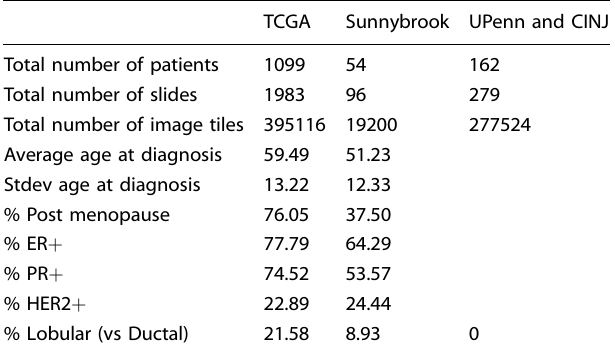
Table 1. Demographics summary of TCGA, Sunnybrook, University of Pennsylvania and the Cancer Institute of New Jersey (UPenn and CINJ)